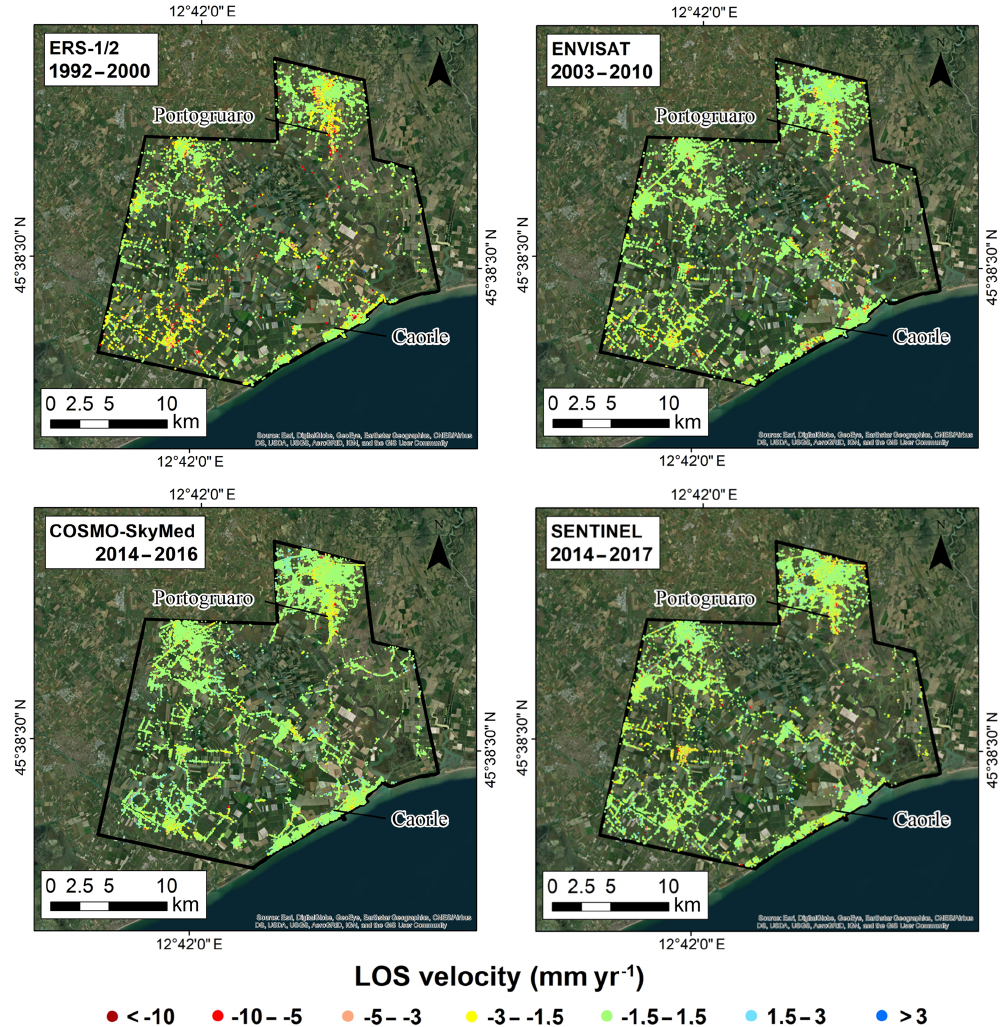
Figure 2. PS velocity maps (mmyr − 1 ) derived by PSI processing of ERS-1/2 (1992–2000), ENVISAT (2003–2010) and COSMO-SkyMed (2014–2016) and Sentinel (2014–2017) SAR data. The black box represents the study